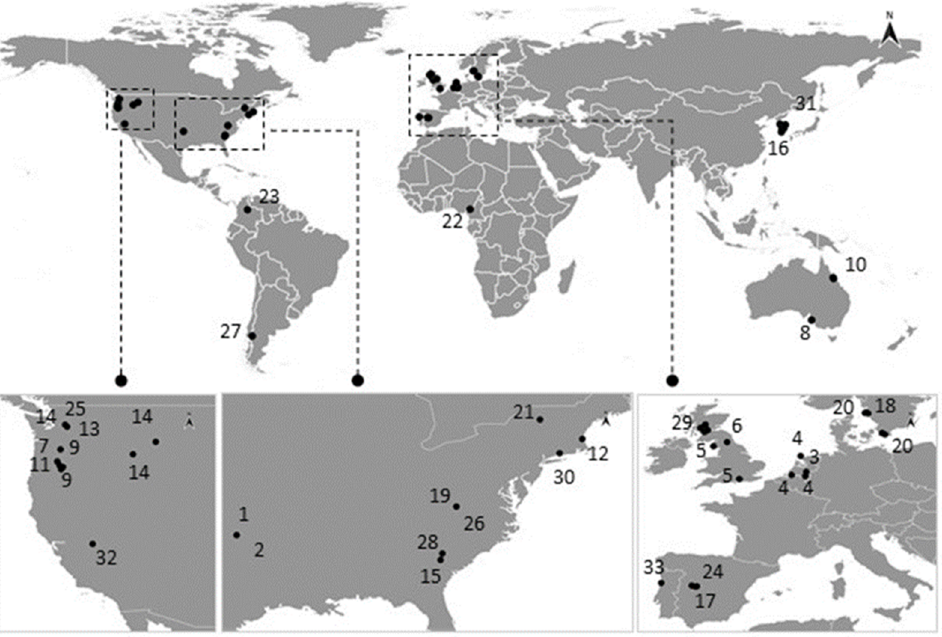
Figure 2. Map showing the geographic distribution of saprolegniosis reports in wild populations. Please see more information in Table 1. Numbers correspond to article reference: (1) Bragg and Bragg [71]; (2) Bragg [56]; (3) Strijbosch [21]; (4) Leuven et al. [22]; (5) Banks & Beebee [23]; (6) Beattie et al. [69]; (7) Blaustein et al. [43]; (8) Williamson & Bull [52]; (9) Kiesecker & Blaustein [44]; (10) Berger et al. [51]; (11) Kiesecker et al. [14]; (12) Gomez-Mestre et al. [41]; (13) Johnson et al.[31] ; (14) Petrisko et al. [61]; (15) Ruthig [68]; (16) Kim et al. [67]; (17) Fernández-Benéitez et al. [48]; (18) Sagvik